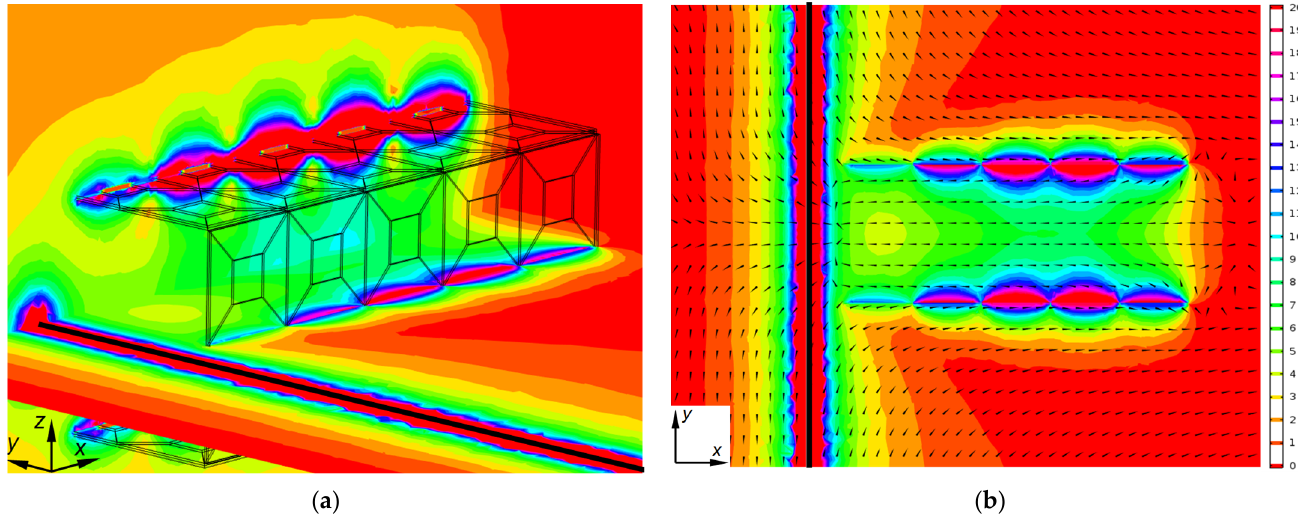
Figure 10. Magnetic field norm (color) and normalized power flow (black arrows) for the model with the highest k = 1.15, i.e., the magnetic meta-hose ( ν = 0.45, µ m = 26) at f r = 100 kHz: ( a ) 3D view on the system with xz and xy cut planes and ( b ) 2D view on xy cut plane.